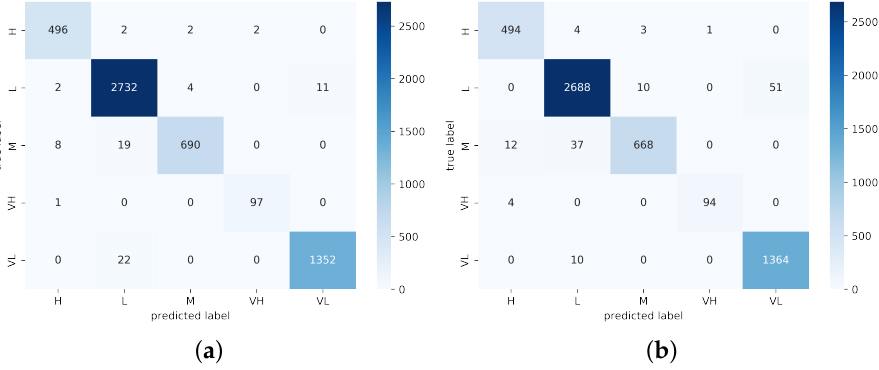
Figure 10. Confusion matrix heat map of UCSD Ped2 for ( a ) MCMS-BCNN-Attention+densenet121 and ( b ) MCMS-BCNN-Attention+Efficientnetv2.